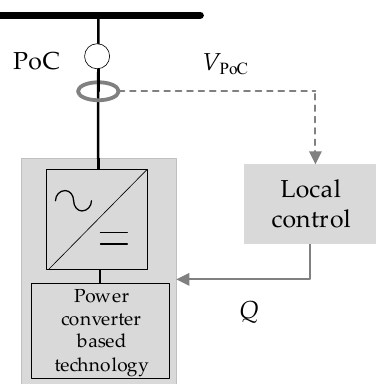
Figure 2. General scheme of the local reactive power control of a DER.